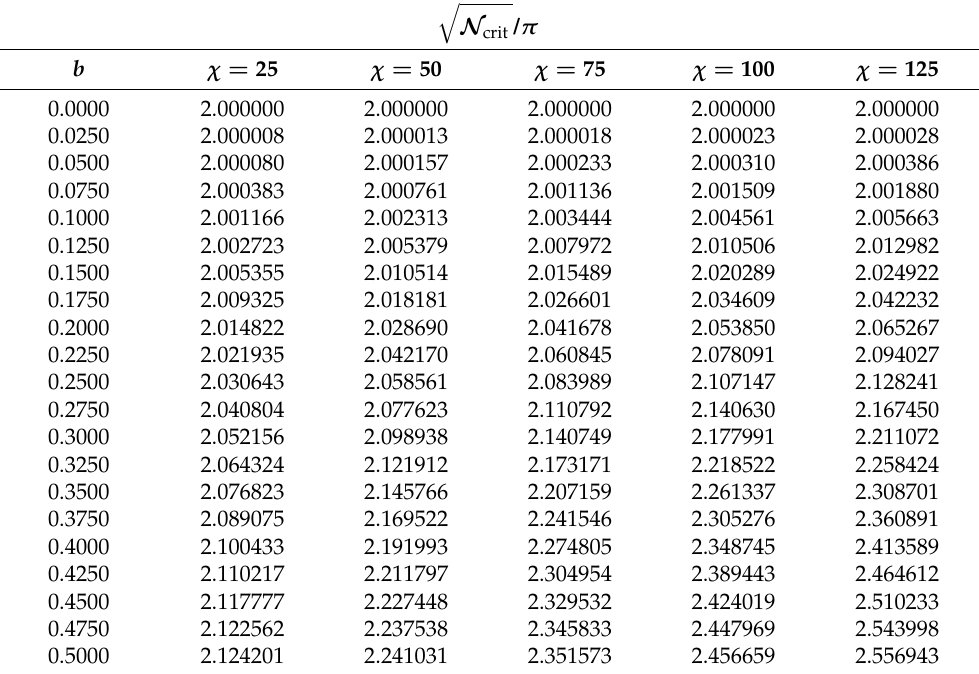
Table 2. The critical forces of FssF beams if χ = 25, . . . ,125.